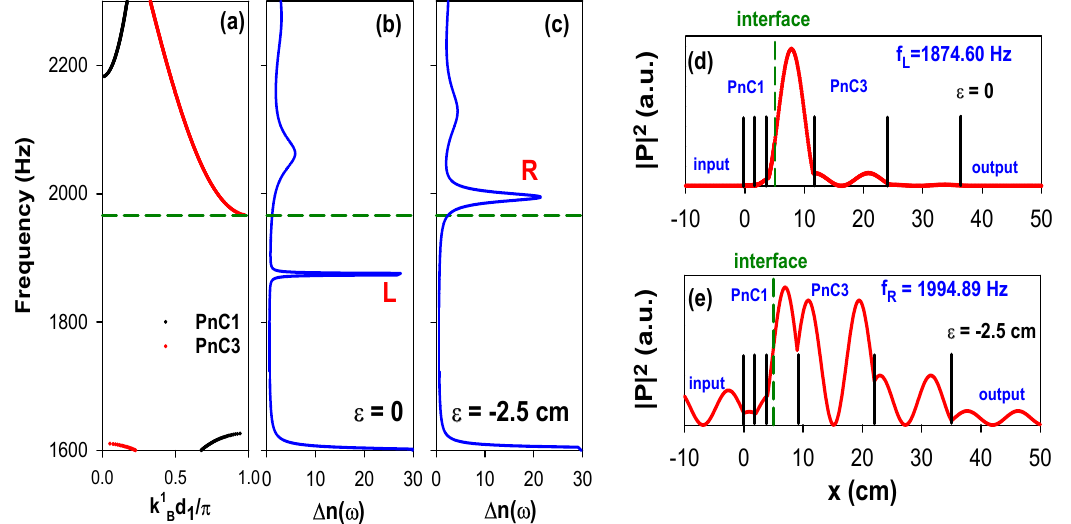
Figure 11. ( a ) Zoom of the dispersion curves for PnC1 with d 1 = 2 cm (black curves) and PnC3 with d 1 = 13 cm (red curves) around the first common bandgap G1. ( b , c ) Variation of the total DOS of a finite PnC composed of PnC1 ( d 1 = 2 cm) and PnC3 ( d 2 = 13 cm) for (cid:101) = 0 ( b ) and (cid:101) = − 2.5 cm in Figure 10. Horizontal dashed line indicates the limit of the bandgap of PnC3. ( d , e ) Square modulus of the pressure field (in arbitrary units) versus the space position along the two combined PnCs for the localized and pseudointerface states at f L = 1874.60 Hz and f R = 1994.89 Hz in ( b ) and ( c ),